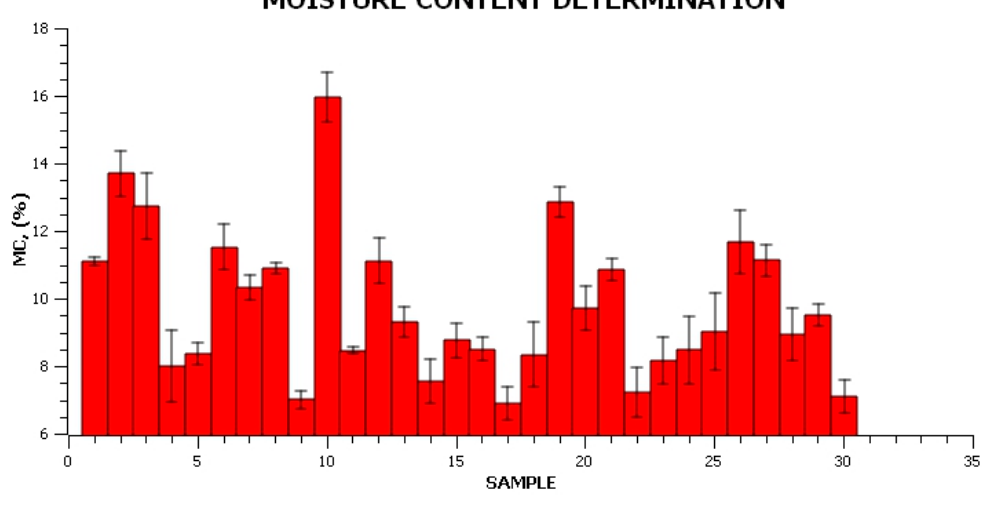
Figure 5. Moisture content evaluation